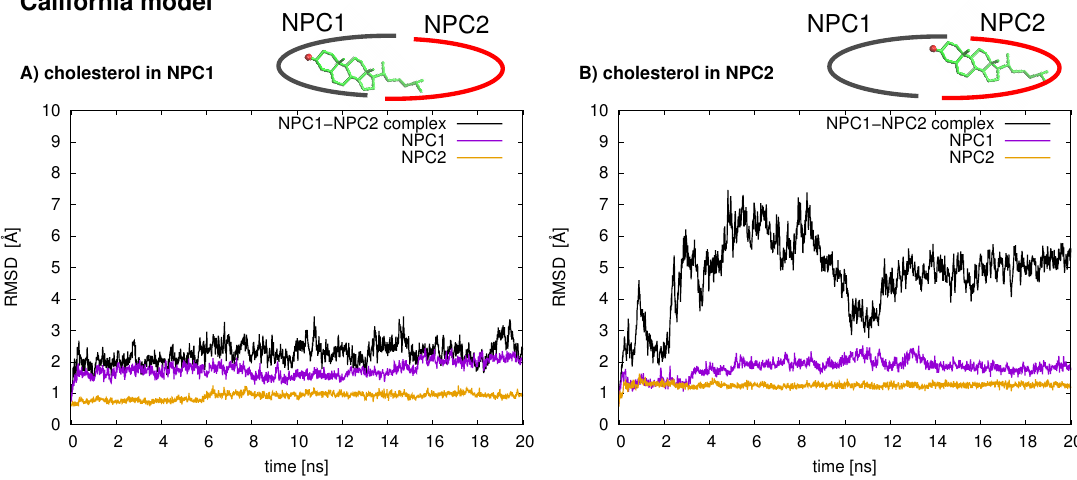
Figure 5. Protein backbone atom RMSD values for the NPC1(NTD)–NP2 complex of the California model. Ref. [11] is shown for: ( A ) with cholesterol in the NPC1 binding pocket; and ( B ) with cholesterol in the NPC2 binding pocket. Black line corresponds to the RMSD for the total protein–protein complex, purple line corresponds to RMSD of NPC1 protein, and orange line corresponds to RMSD of NPC2